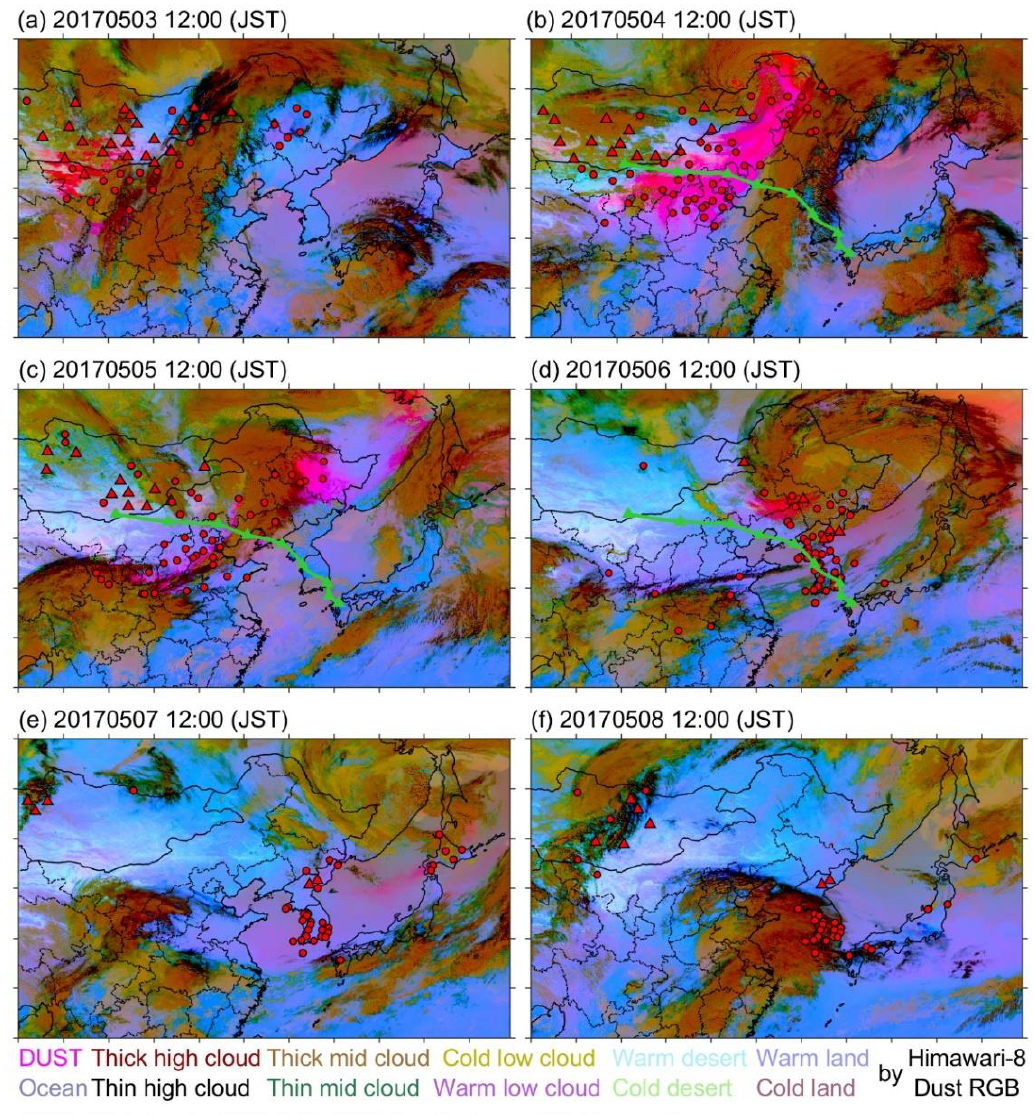
Figure 2. Dust RGB imageries with the surface synoptic observations (SYNOP) sites where dust weather occurred (red triangle for dust storm and circle for drifting and blowing dust) on each day ( a – f ) between 3 May and 8 May 2017 (JST). The green lines with triangle markers (every 6 h) in ( c ) and ( d ) show the 48-h backward trajectory from Fukuoka at 20:00, on 6 May 2017 (JST). The simulated daily horizontal distribution of dust concentration between 3 and 10 May 2017 at